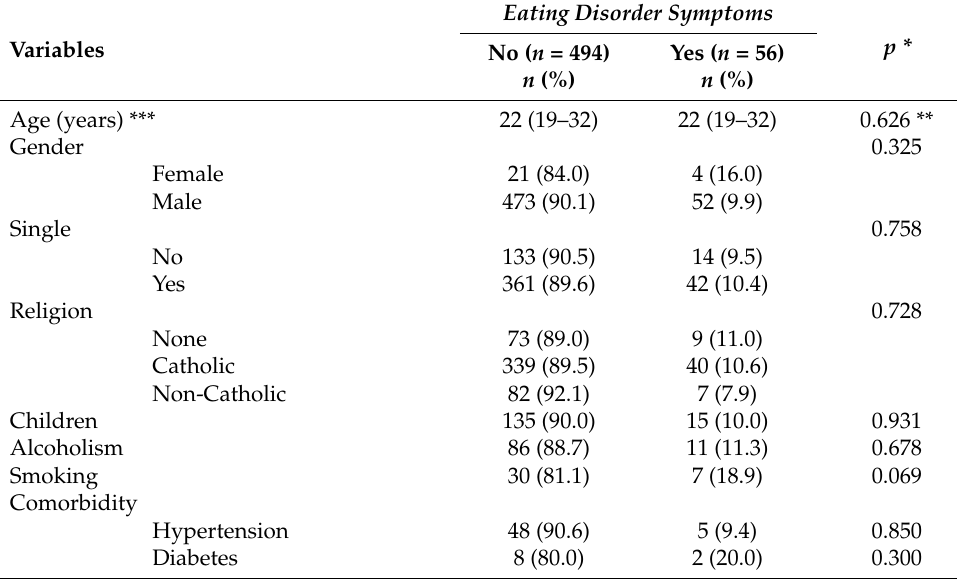
Table 2. Factors associated with eating disorder symptoms in bivariate analysis.